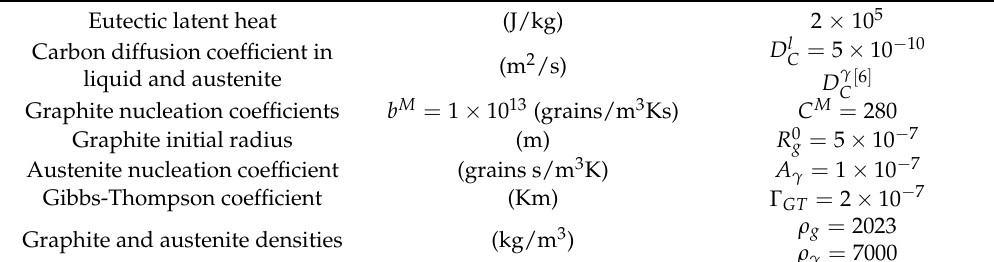
Table A2. Thermo-physical properties of SGI: solidification phase change model [21].